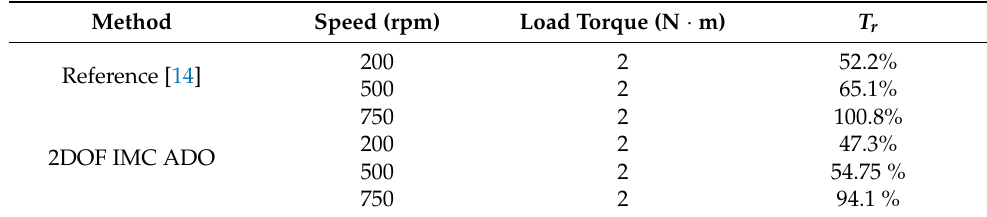
Table 2. The torque ripple percentages for both methods when the reference speed